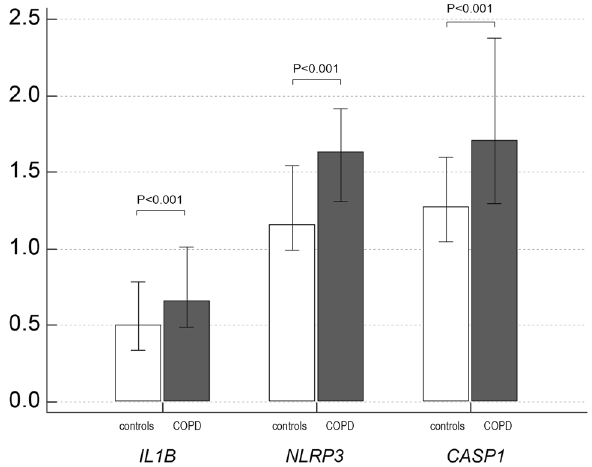
Figure 1. Relative gene expression of IL1B , NLRP3 and CASP1 in control and COPD groups. IL1B interleukin- 1beta gene, NLRP3 nucleotide-binding oligomerization domain-like receptor family pyrin domain-containing 3 gene, CASP1 caspase-1 gene, COPD chronic obstructive pulmonary disease. Mann–Whitney test was used for comparison of IL1B , NLRP3 and CASP1 relative expression between controls and COPD patients. Results were presented as a median and